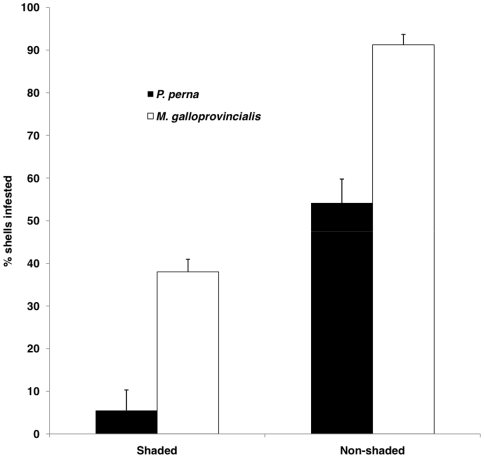
Degrees of infestation of different size classes: micro-scale comparison between bays and open coast.Proportions of shells exhibiting different degrees of infestation severity (Groups A–E, see Fig. 1) and grouped into 10 mm size classes. Infestation severity was determined in the mid-mussel zone at (a) bay and (b) open coast habitats for P. Perna and at (c) bay and (d) open coast for M. galloprovincialis.